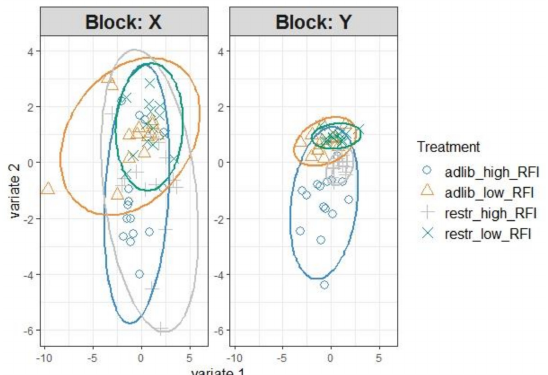
Figure 1. Sample plot of sparse partial least-squares regression with 95% confidence ellipse plots of serum metabolome (Block: X) and total feed intake, total body weight gain, and residual feed intake (RFI; Block: Y) of low and high residual feed intake (RFI) broiler chickens fed either ad libitum or restrictively. adlib, ad libitum feeding; restr, restrictive feeding.